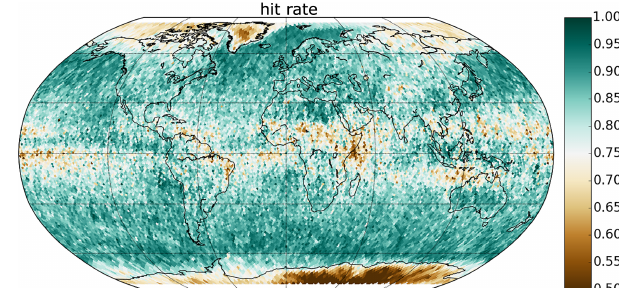
Figure 5. Global presentation of the CLARA-A2 cloud mask hit rate parameter with a horizontal Fibonacci grid resolution of 75km. Validation results are based on comparisons with the original CALIPSO-CALIOP cloud mask. Same underlying matchup data set as in Fig. 2.